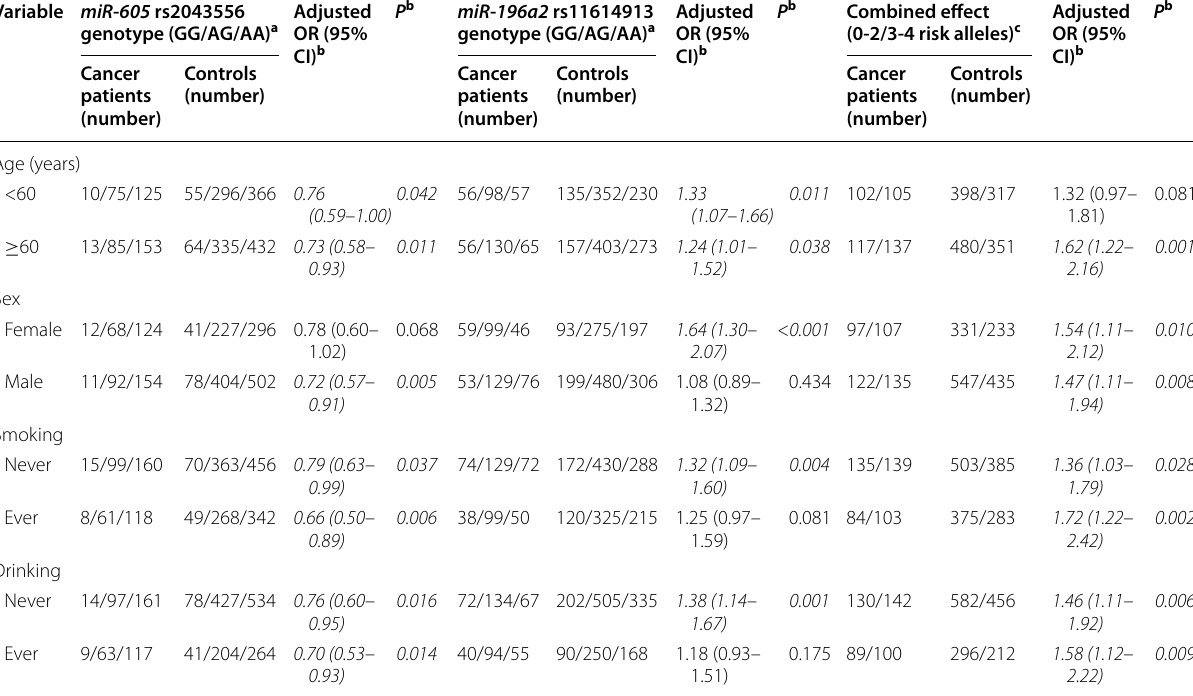
Italic value indicate significance of p value ( p < 0.05)